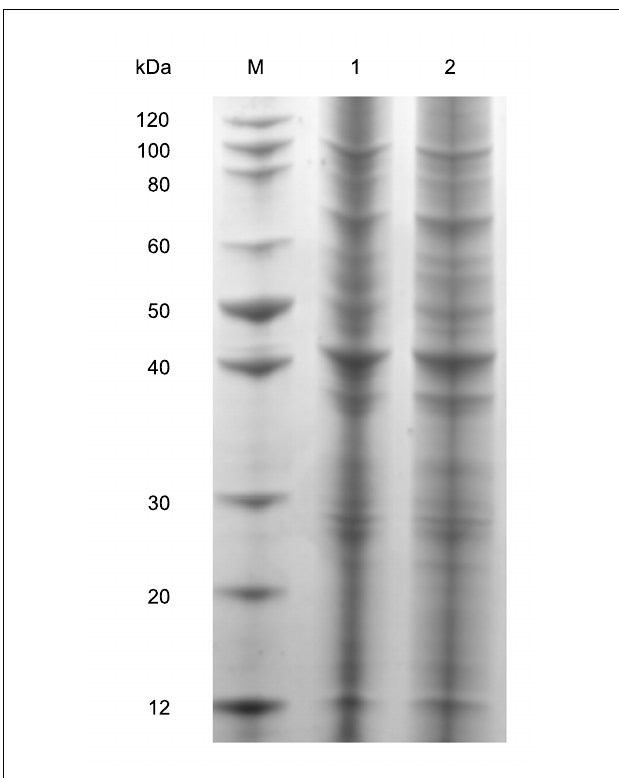
FIGURE 1 | Separation of complete proteins of adult schistosomes from water buffalo and yellow cattle. 1: from yellow cattle; 2: from water buffalo.